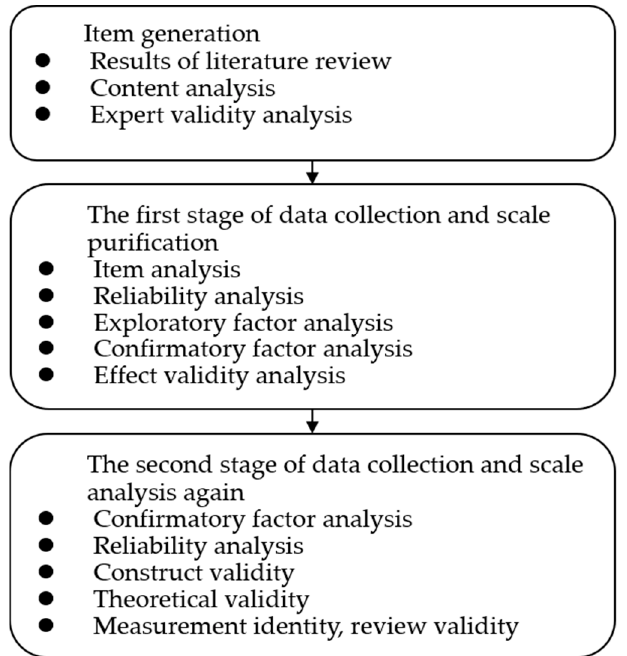
Figure 1. Scale development